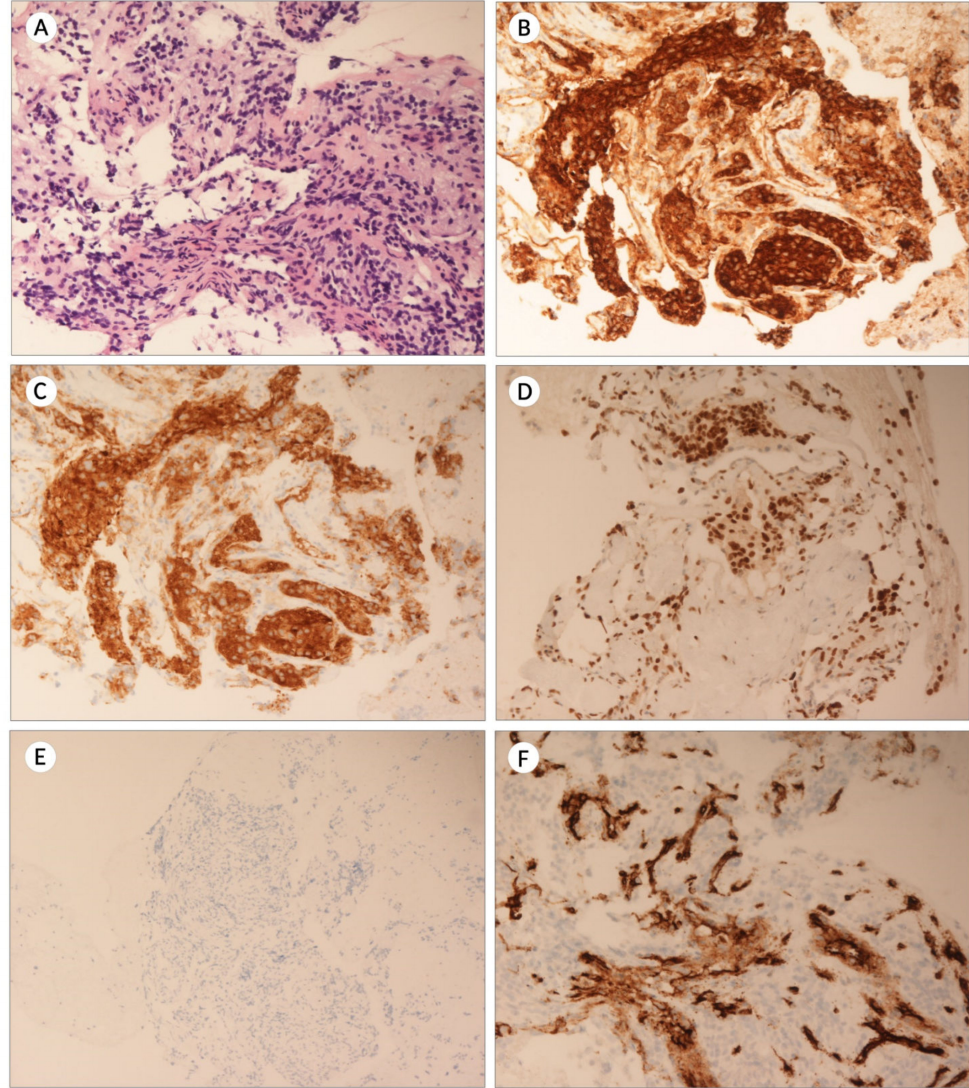
Figure 2. Representative images of a paraduodenal paraganglioma from our practice diagnosed with EUS-FNB, with a combination of H&E histomorphology and immunohistochemistry. ( A ), H&E × 200; ( B ), Chromogranin × 200; ( C ), Synaptophysin × 200; ( D ), GATA-3 × 200; ( E ), Keratin × 100; and ( F ), CD34 ×